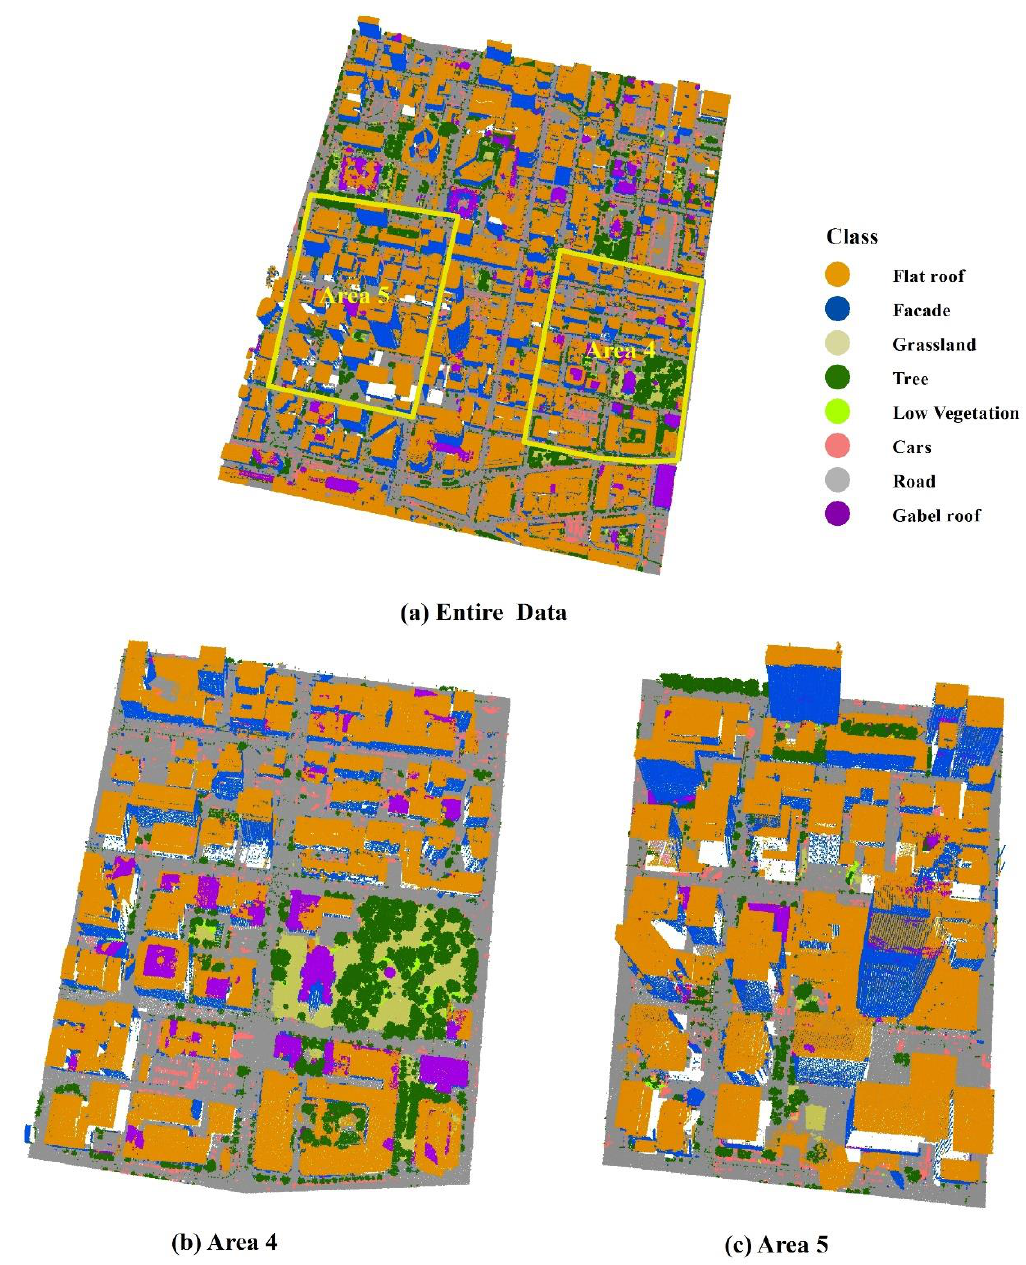
Figure 7. Three-dimensional view of the classification results for the Toronto data set.